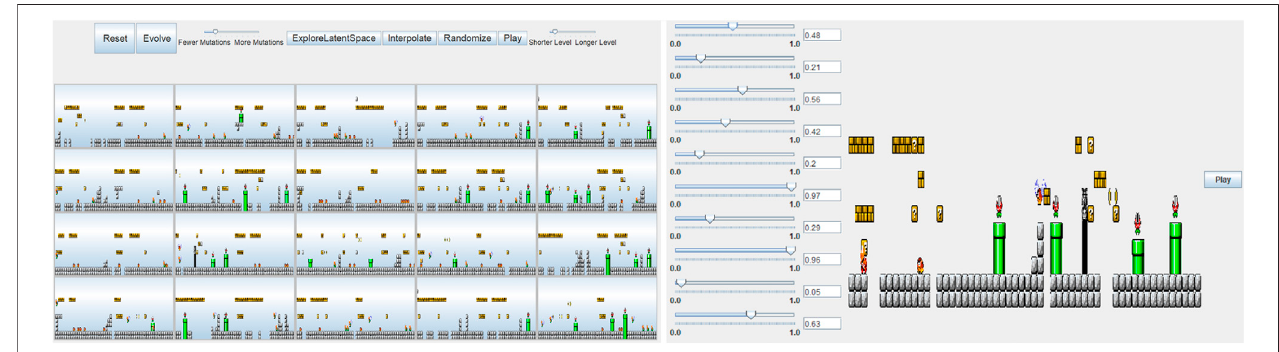
FIGURE 8 | The level design interface designed by Schrum et al. (2020). Left: The user can select any number of level segments with desired features and evolve new segments. Right: The user can further re fi ne segments through direct manipulation of latent vector values.